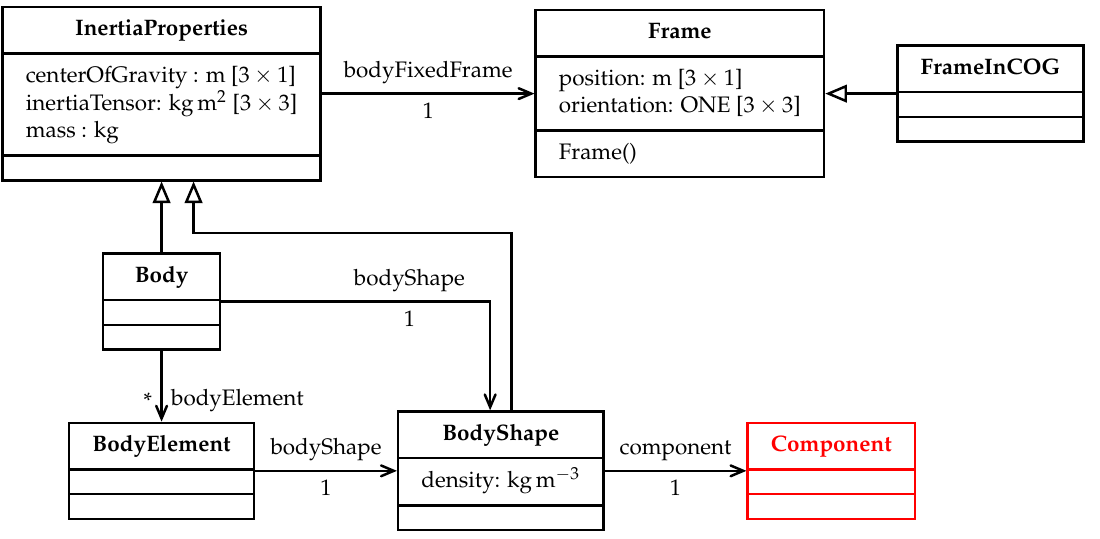
Figure 23. Class diagram of a multibody library.